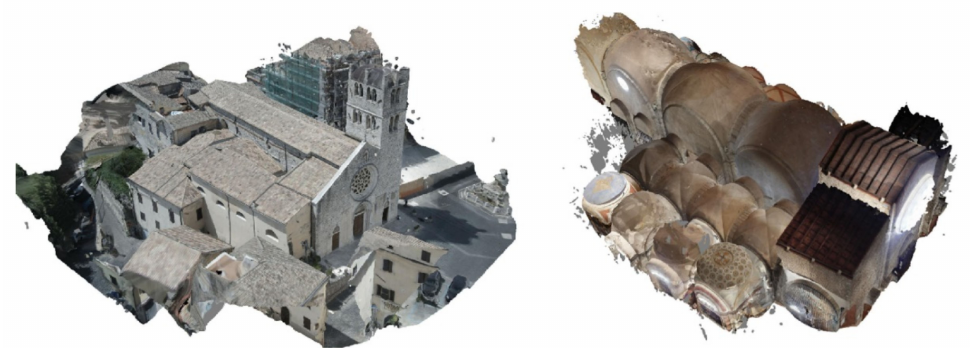
Figure 2. High-density point cloud with applied texture of the: ( left ) exterior and ( right ) interior of the church of Santa Maria Maggiore